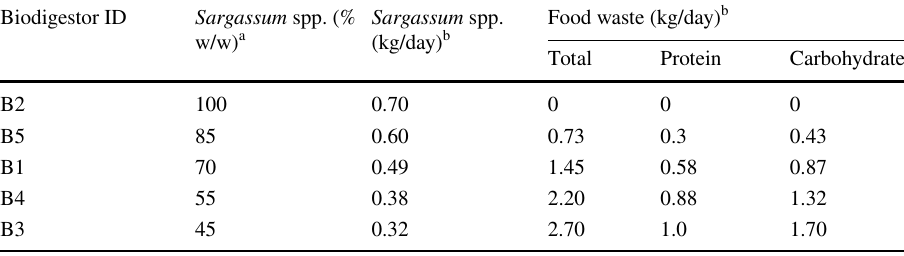
a Values on the dry weight basis for Sargassum spp. biomass and food waste b Values on as received basis for food waste (15% TS) and air-dried basis for Sargassum spp. biomass